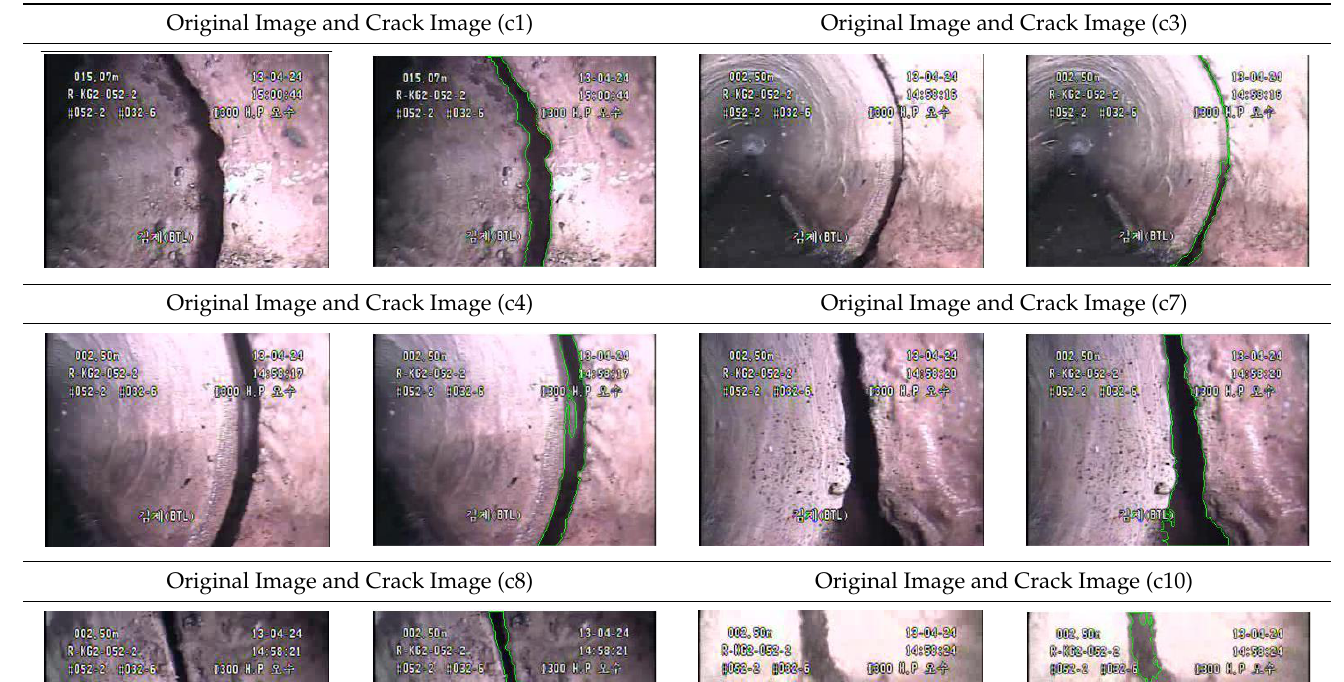
Table 12. Excellent results of crack images (only 12 results).